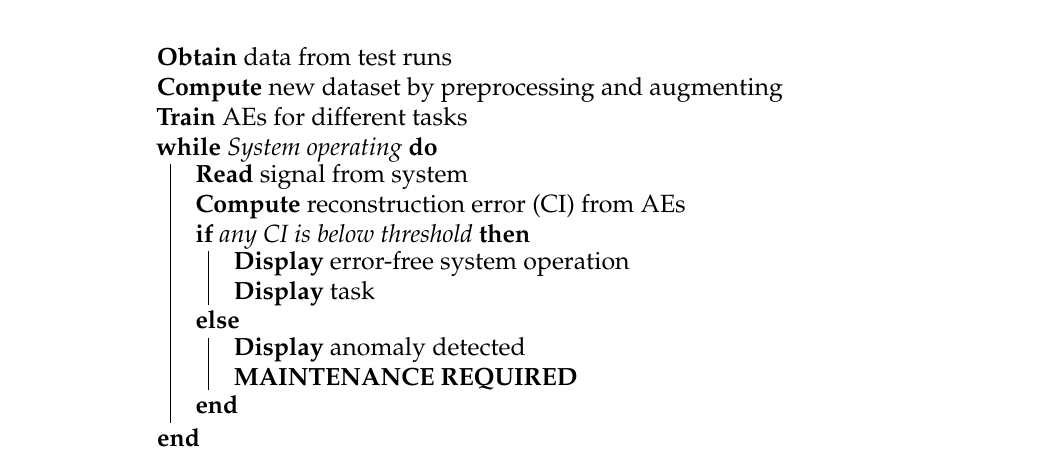
Figure 9. Pseudo-code of the binary classification for erroneous and normal working conditions.